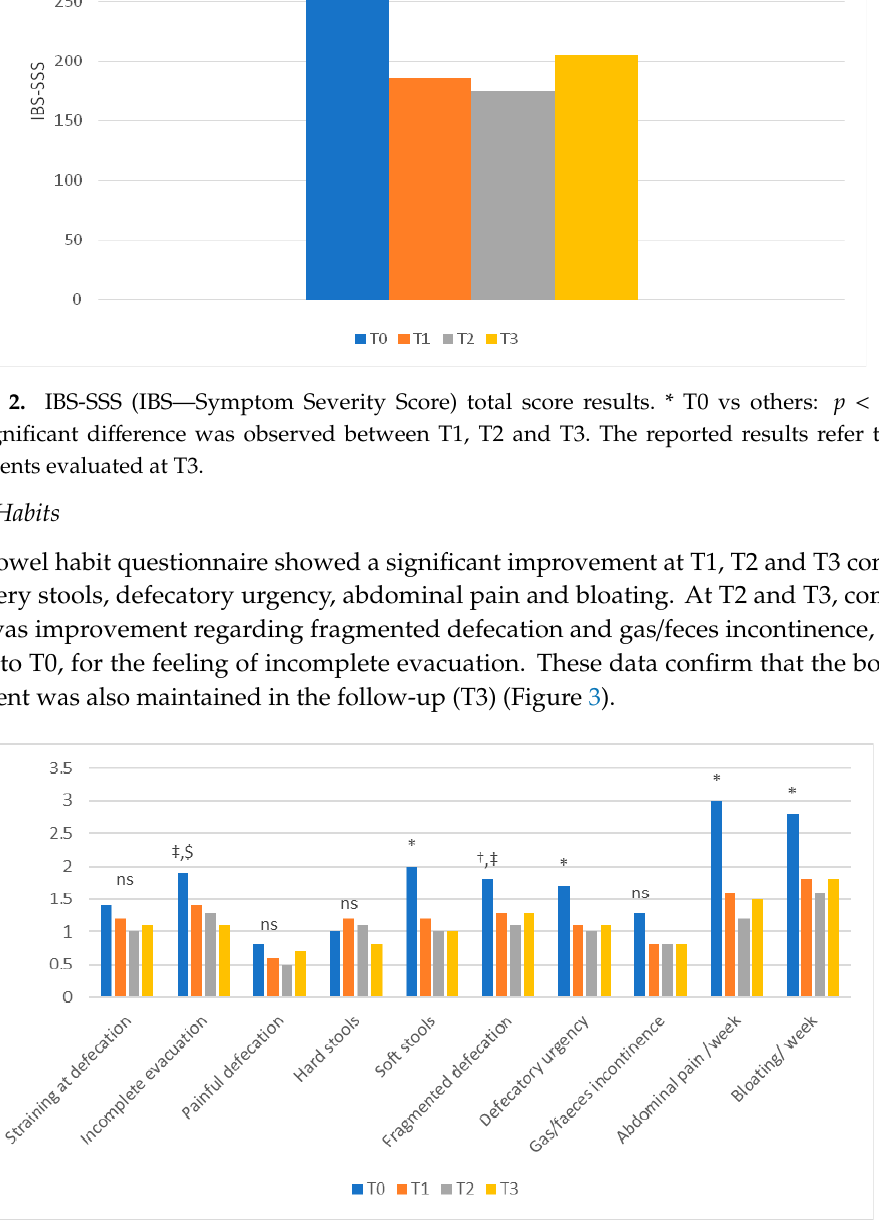
T3 Figure 4. SF-36 results. * T0 vs other: p < 0.05; † T0 vs T1: p < 0.05; ns: not significant. The reported results refer to the 41 patients evaluated at T3. 3.5. Hospital Anxiety and Depression Scale (HADS)